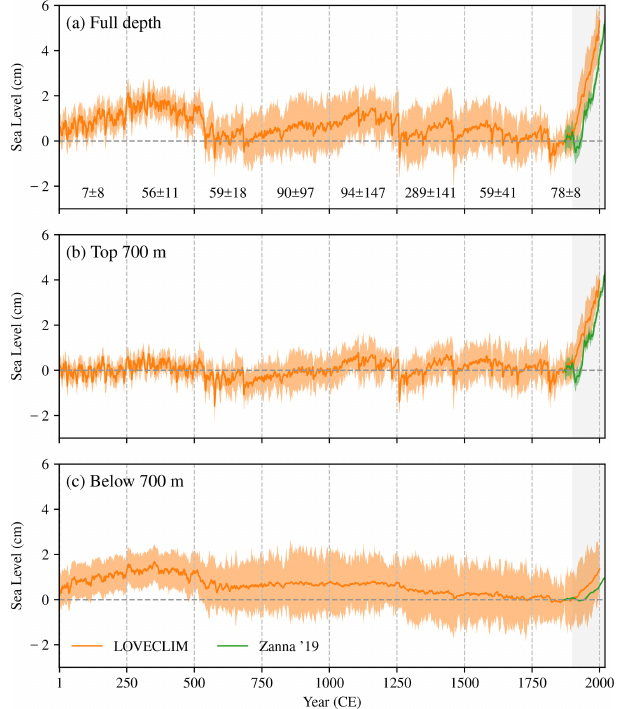
Figure 1. Global-mean thermosteric sea level from LOVECLIM climate model simulations (orange; 1–2000 CE) and Zanna et al. (2019) reconstruction (green; 1870–2018) for (a) full depth, (b) top 700m and (c) below 700m. All curves are referenced to 1870CE (when the reconstruction begins), and the shading indi- cates the 1 σ confidence level of the ensemble mean curve. The con- tribution of change in the top 700m thermosteric level to that of the full depth (as percentage), estimated over chunks of 250-year pe- riods (vertical dashed lines), is shown in panel (a) . The estimated 1900–2000 CE (period shown by grey shading) contribution of the upper 700m for Zanna et al. (2019) reconstruction (LOVECLIM) is 86% (74 ±